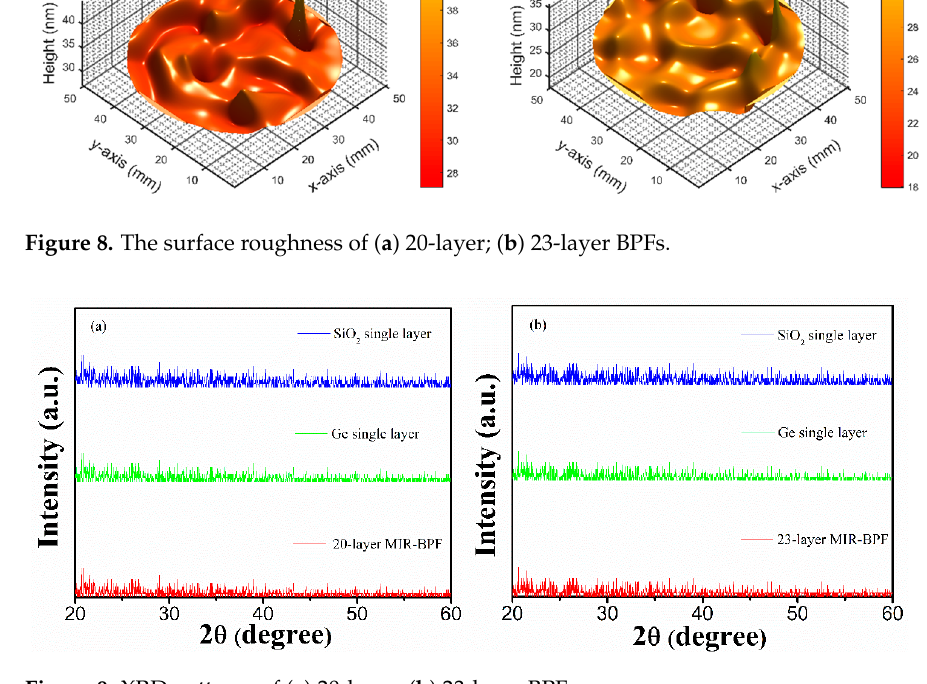
Figure 9. XRD patterns of ( a ) 20-layer; ( b ) 23-layer BPFs.